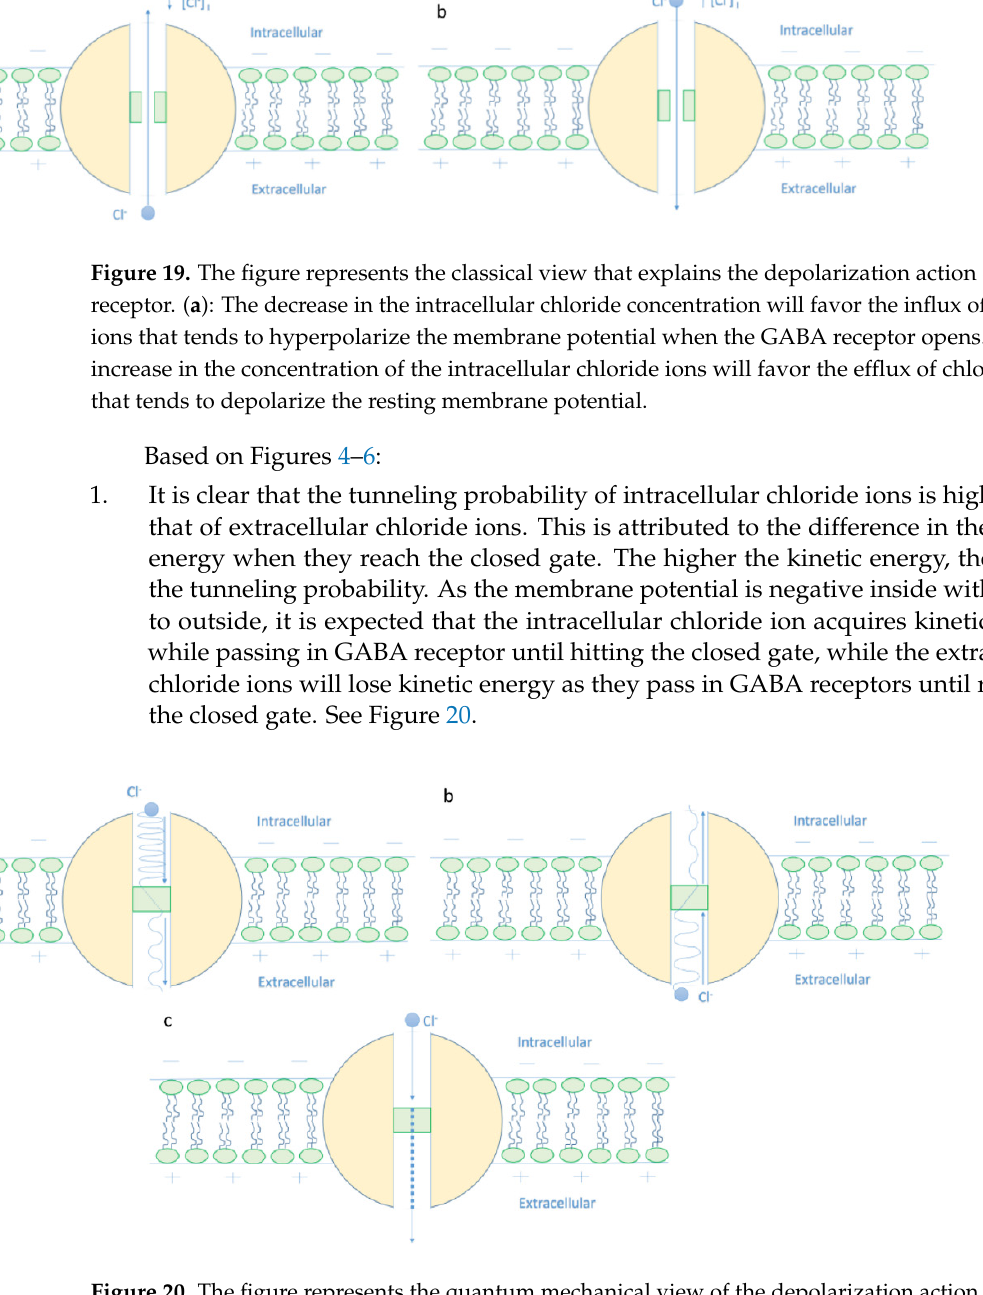
Figure 20. The figure represents the quantum mechanical view of the depolarization action of GABA receptor. ( a ): The intracellular chloride ion with higher kinetic energy, which is represented by a higher quantum wave frequency, has a higher quantum tunneling probability through the closed gate, which is represented by a higher wave amplitude after passing the gate. ( b ): The extracellular chloride ion with a lower kinetic energy, which is represented by a lower quantum wave frequency, has a lower quantum tunneling probability through the closed gate, which is represented by a lower wave amplitude after passing the gate. ( c ): Due to the discrepancy between the intracellular and extracellular chloride ions in terms of the tunneling probability, a quantum gradient favors the efflux of chloride ions, which will depolarize the membrane potential. The quantum efflux gradient is represented by a dotted